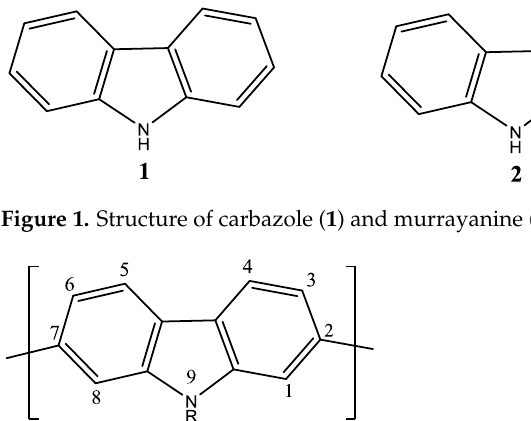
Figure 1. Structure of carbazole ( 1 ) and murrayanine ( 2 ).